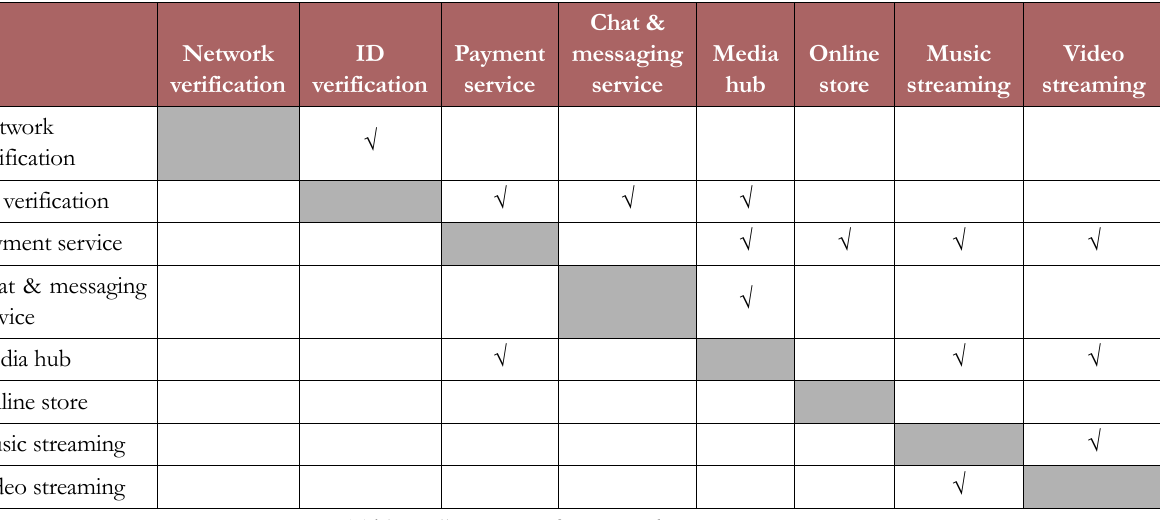
Table 3. Illustration of a Dependency